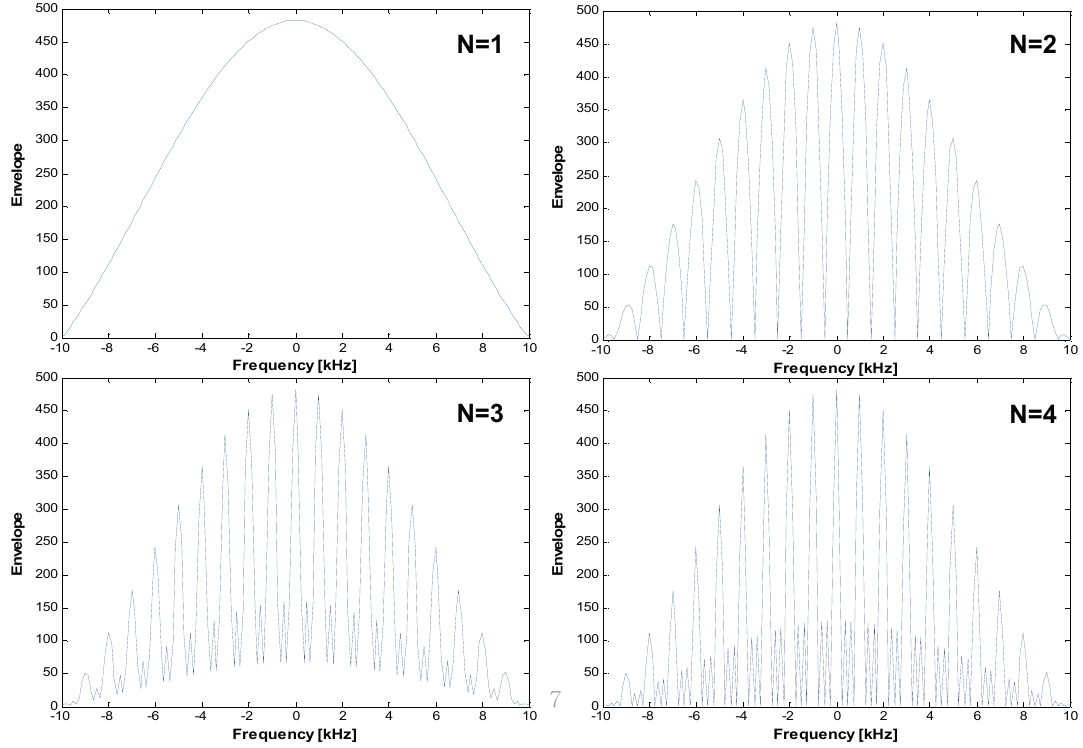
Figure 5. Auto-correlation function ( N = the number of coherent integrations in sequence